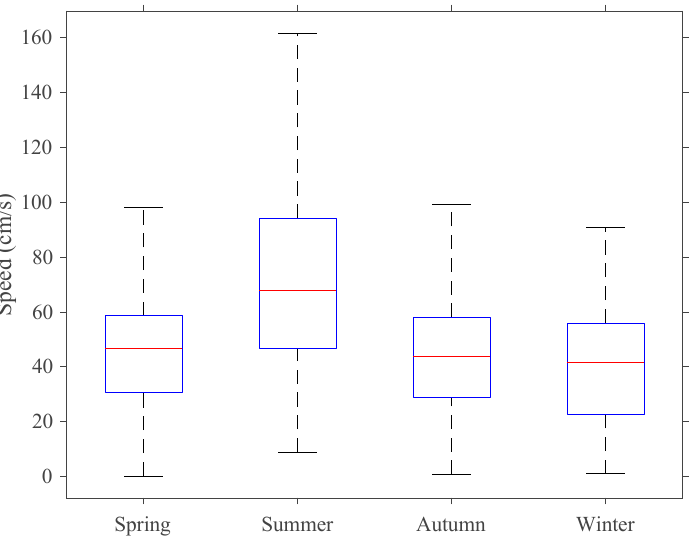
Figure 5. Box plots of the sea-surface currents for the four seasons. A five-value summary is shown for each dataset, including the minimum, first ( lower ) quartile, median (red line), third ( upper ) quartile, and maximum.